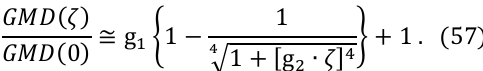
Figure 6: Semi logarithmic plot of the reference and the approximated GMD in function of the dimen- sionless frequency 𝜁 .